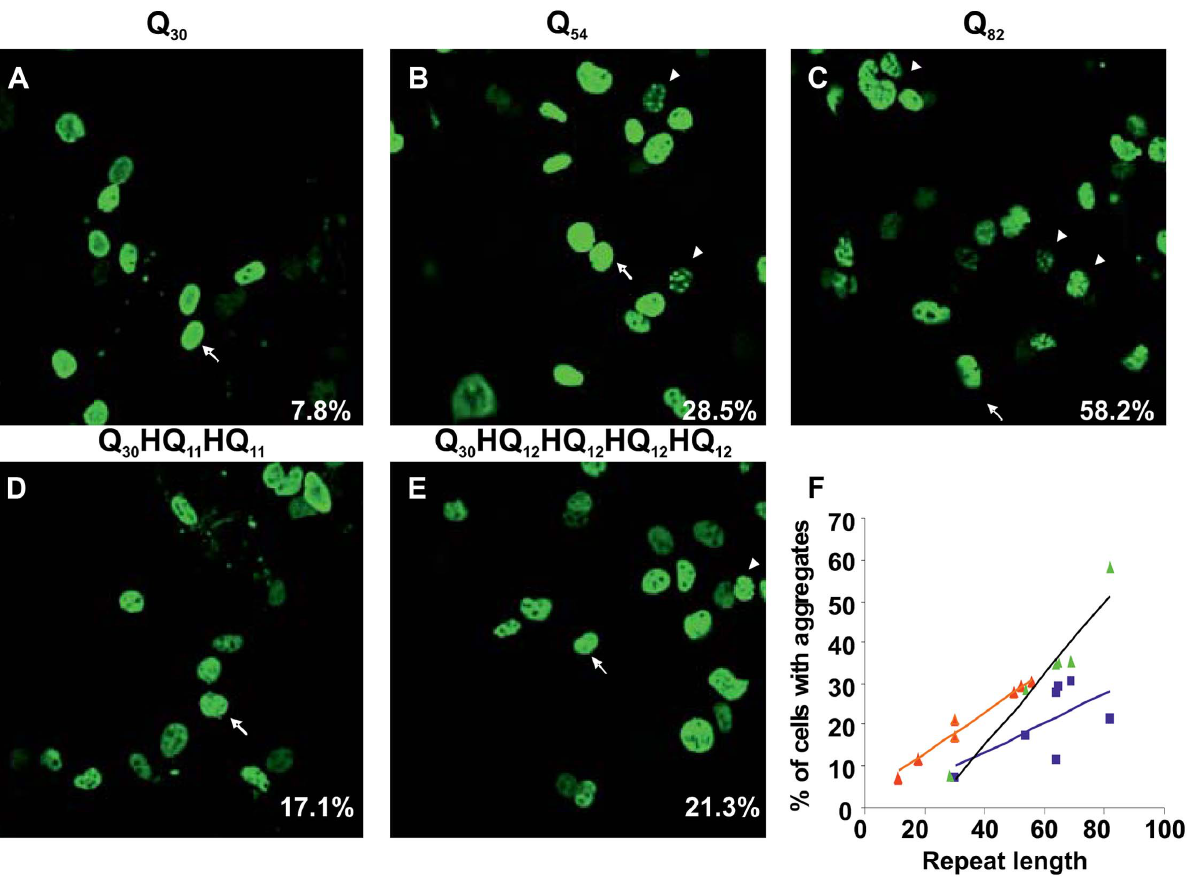
Figure 3. Interruption of the expanded polyQ stretch by histidines reduces its aggregation in transfected cells. COS cells were transfected with uninterrupted ( A, B and C ) or His interrupted polyQ-ataxinCT constructs ( D and E ). The repeat pattern is shown above each panel. Cells were stained with anti-ataxin-1 antibodies and FITC conjugated secondary antibodies. The % of cells with aggregates (average from at least 3 different experiments) is shown at bottom right hand corner of each panel. Arrows indicate cells with diffused expression of ataxinCT proteins and arrowheads indicate aggregates. ( F ) Analysis of the data in Table 1 plotting the percentage of aggregates observed in cells expressing uninterrupted polyQ proteins (green triangles, R 2 =0.94) and His-interrupted polyQ proteins plotted either against total repeat length (blue squares, R 2 =0.40) or against the longest polyQ tract length (orange triangles, R 2 =0.97). The regression lines and the R 2 values were calculated using Microsoft Excel.